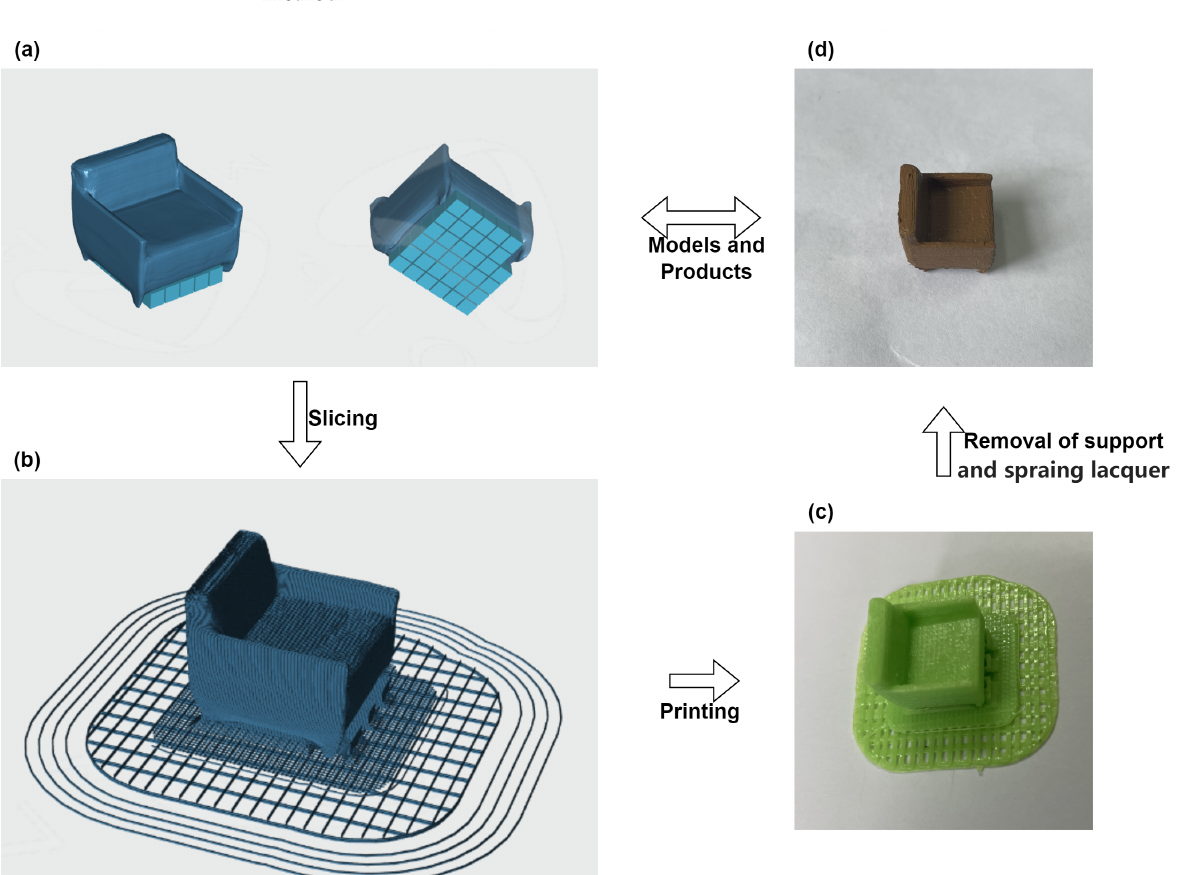
Figure 6. The printing process of